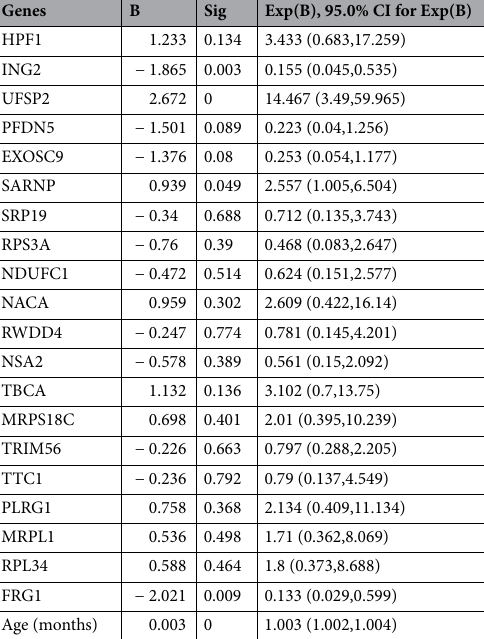
Table 1. Covariates present in multivariate Cox regression model in breast cancer